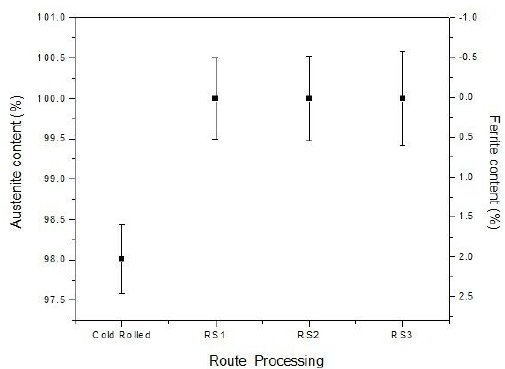
Figure 5. Volumetric fractions of ferrite and austenite in the 316L stainless steel under the following conditions: cold rolled, RS1, RS2 and RS3.